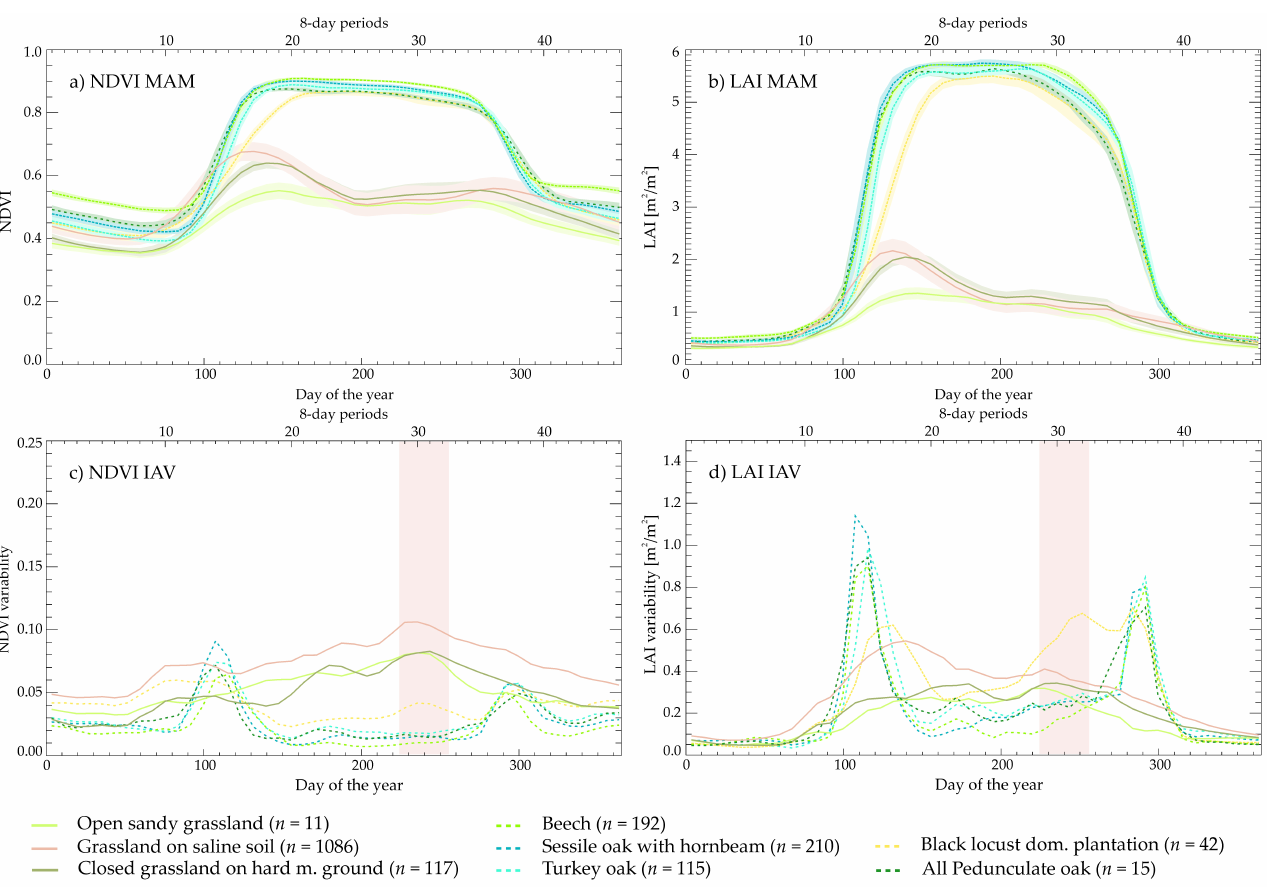
Figure 4. Multiannual mean (MAM) and interannual variability (IAV) curves of each ecosystem cate- gory based on NDVI and LAI, derived from the selected pixels. The range of the ± 1.96 SE MAM based on the yearly country averaged curves are also shown for the MAM curves. Pink rectangles/columns indicate the period of interest (PI) in late summer (DOY 225–256, 13 August–13